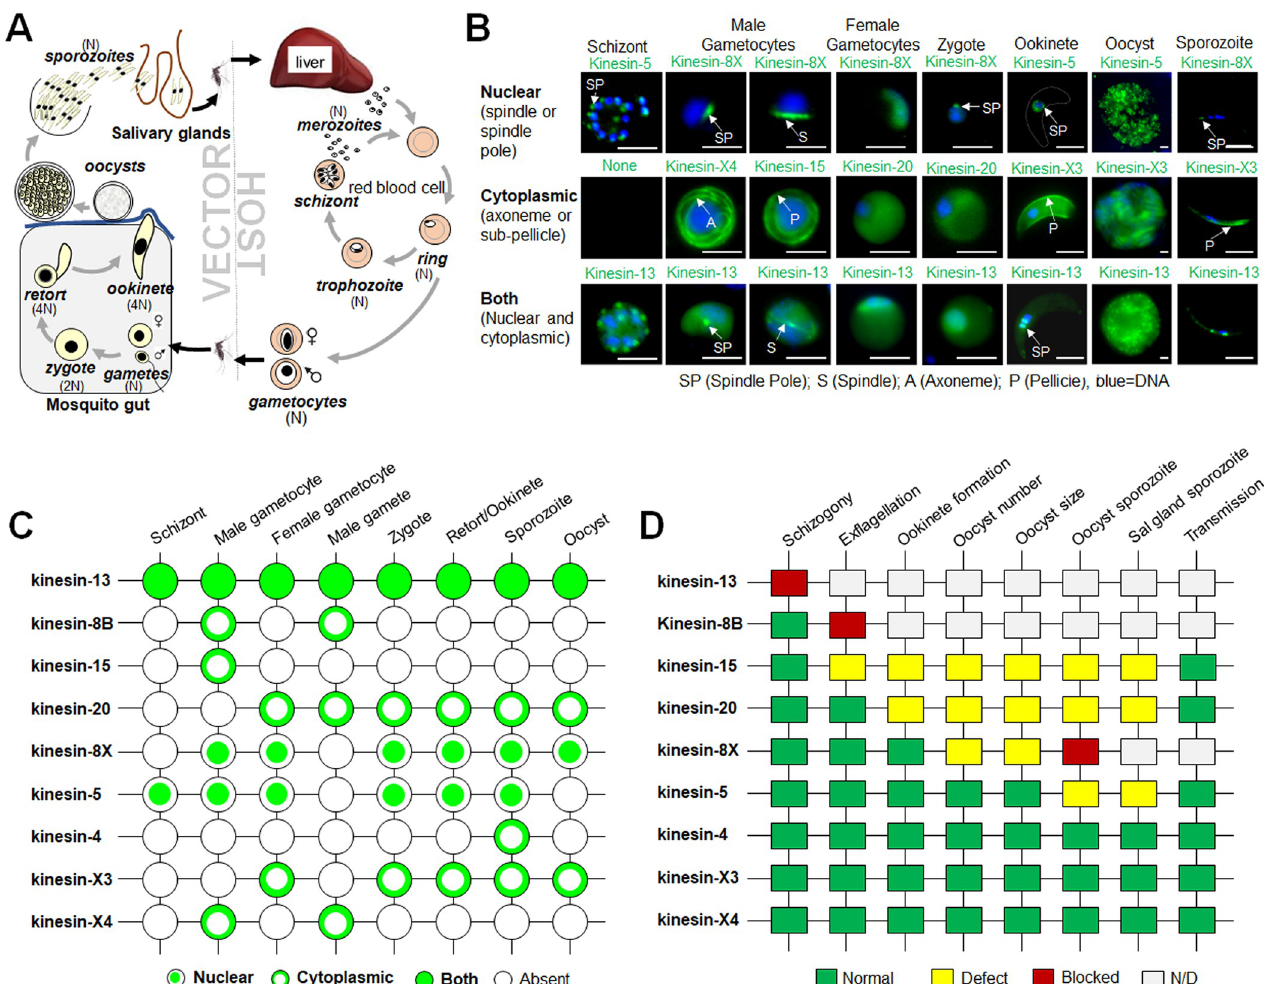
Fig 1. Subcellular location and function of kinesins at various stages of the Plasmodium berghei life cycle. (A) Life cycle of Plasmodium spp. showing different proliferative and invasive stages in host and vector. (B) Live cell imaging showing subcellular locations of representative kinesin-GFP proteins (green) during various stages of the P . berghei life cycle. DNA is stained with Hoechst dye (blue). Scale bar = 5 μ m. (C) A summary of expression and location of kinesins-GFP during different stages of P . berghei life cycle. (D) Summary of phenotypes resulting from deletion of different kinesin genes at various stages of life cycle. The phenotype was examined for asexual blood stage development (schizogony), exflagellation (male gamete formation), ookinete formation, oocyst number, oocyst size, sporozoite formation in oocyst, presence of salivary gland sporozoites, and sporozoite transmission to vertebrate host. N/D, not